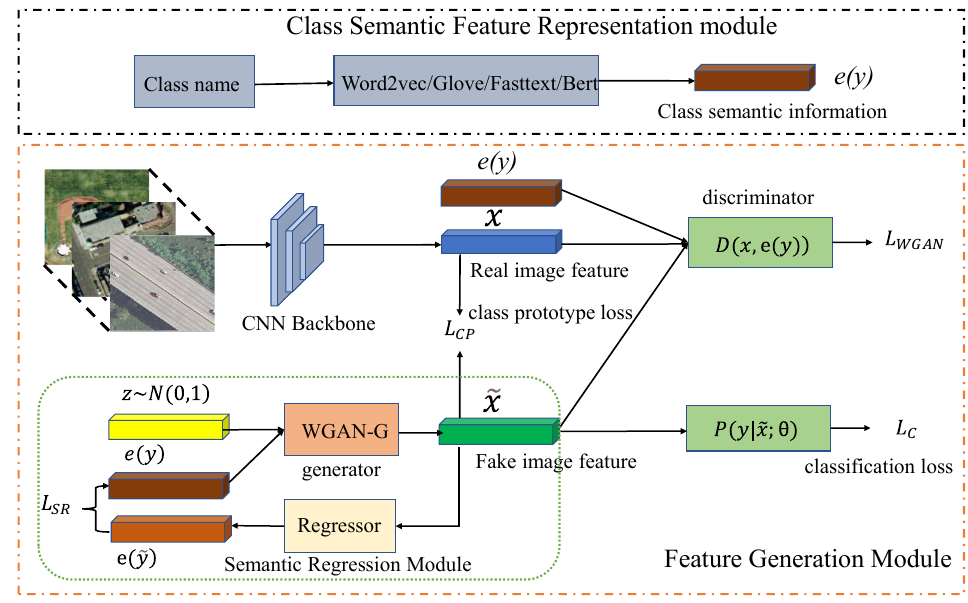
Figure 1. The framework of our proposed CSPWGAN model for zero-shot